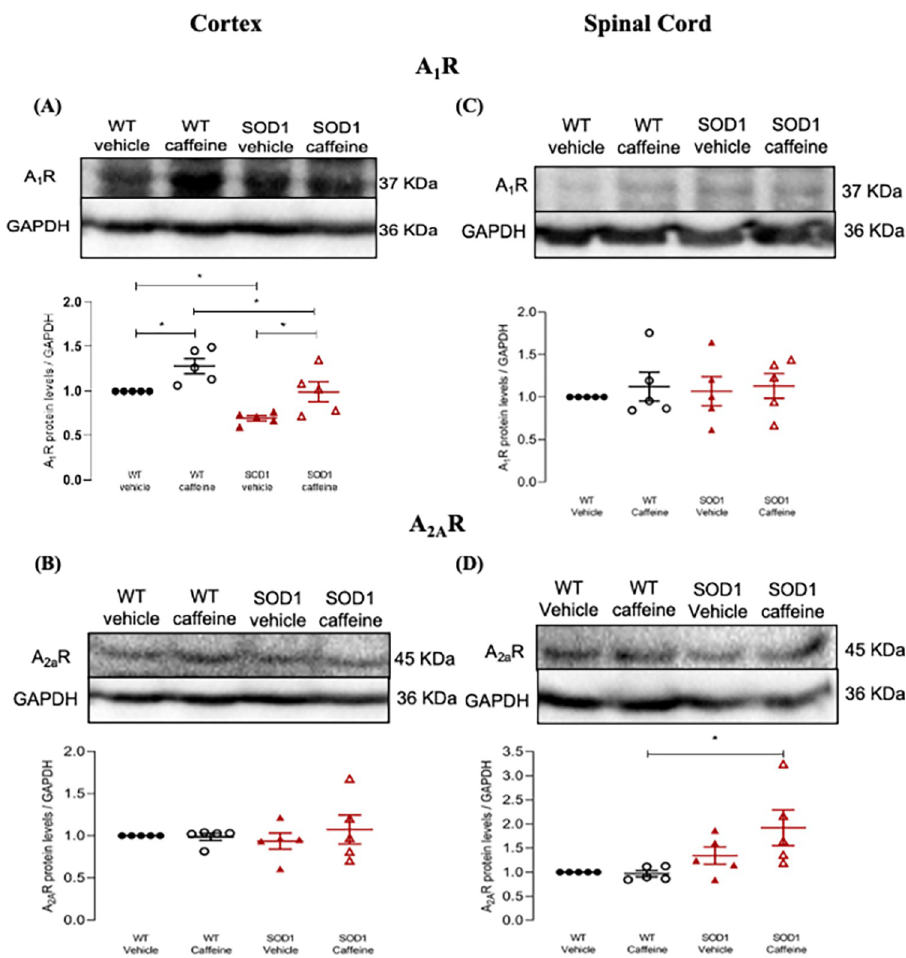
Fig 7. A 1 R and A 2A R protein levels in the cortex and spinal cord of WT and SOD1 G93A mice treated/non-treated with caffeine. A 1 R (A, C) and A 2A R (B, D) protein levels determined by Western Blot in samples from the cortex (A, B) or spinal cord (C, D) of late-stage SOD1 G93A mice (16–18 weeks old) or age-matched WT mice treated/non-treated with caffeine, as indicated below each data set. The Y-axis represents the receptor/GAPDH ratios normalized to values in samples from WT mice not treated with caffeine. Caffeine administration in the drinking water (see methods) started when animals were 11 weeks old. Upper panels show representative immunoblots for each condition. Data are expressed as mean ± SEM (n = 5 animals for all conditions); � p < 0.05, two-way ANOVA with Holm-Sidak correction for multiple